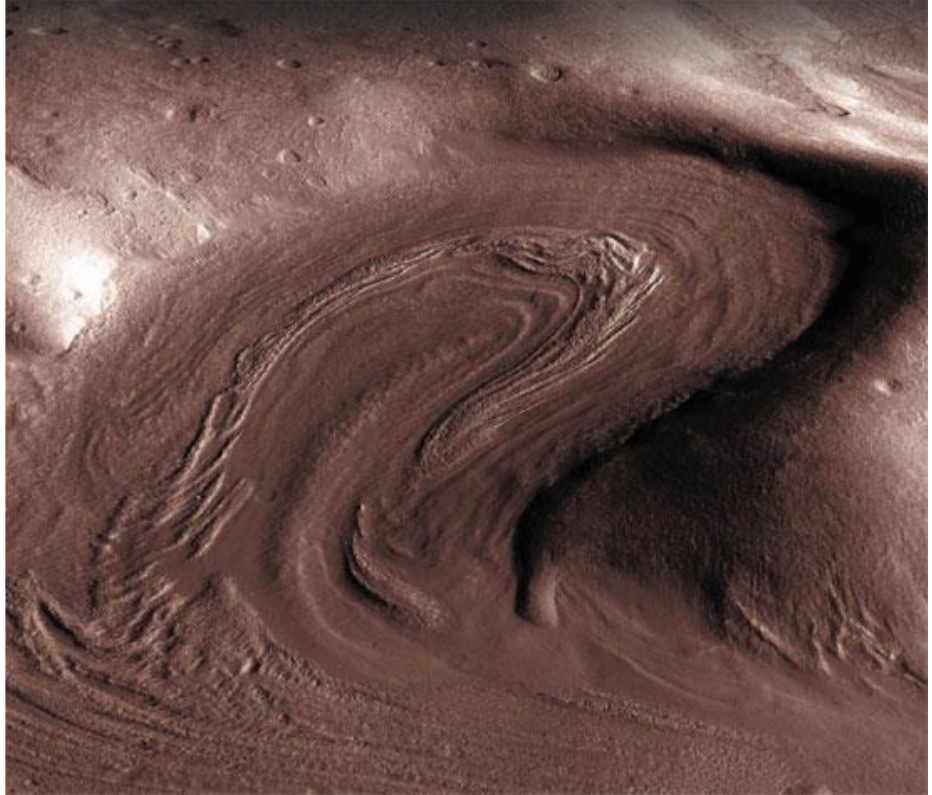
Figure 13. View of a 5-km-wide, glacial-like lobe deposit sloping up into a box canyon. The surface has moraines, deposits of rocks that show how the glacier advanced.